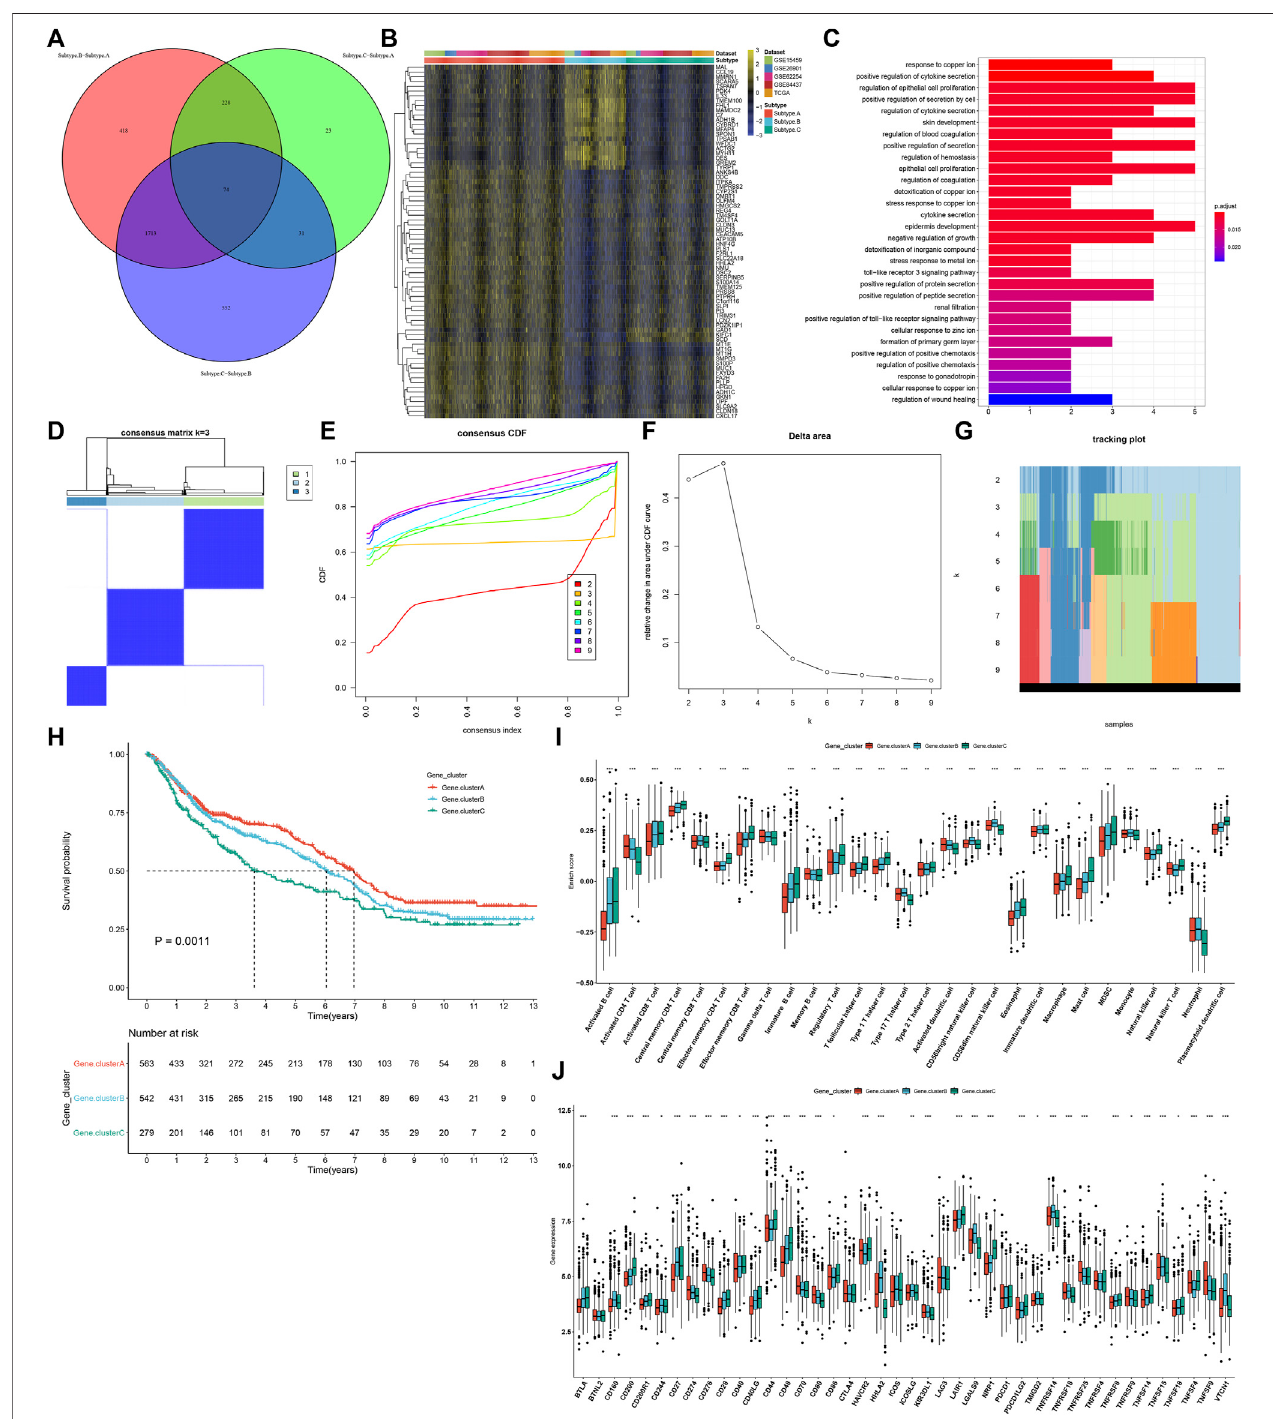
FIGURE 4 | Identi fi cation of three ferroptosis genomic subtypes characterized by different prognosis and TME features in the GC meta-cohort. (A) Shared DEGs between three ferroptosis subtypes. (B) Heatmap showing the mRNA expression of the shared DEGs in each ferroptosis subtype. Yellow, up-regulation; blue, down- regulation. (C) GOannotationresultsofthesharedDEGs. (D) Consensusmatrixwhenk=3. (E) EmpiricalCDFplotsdisplayingtheconsensusdistributioncorresponding to each k. (F) Delta area diagram visualizing the relative change in area under CDF curve at different k. (G) Item tracking plot showing the consensus clustering of items (in column) at each k value (in row). (H) Survival analysis of GC patients in three ferroptosis genomic subtypes. (I) Comparison of the relative abundance of tumor- in fi ltrating immune cells among three ferroptosis genomic subtypes. (J) Comparison of the mRNA expression of immune checkpoints among three ferroptosis genomic subtypes. * p < 0.05; ** p < 0.01; *** p < 0.001.